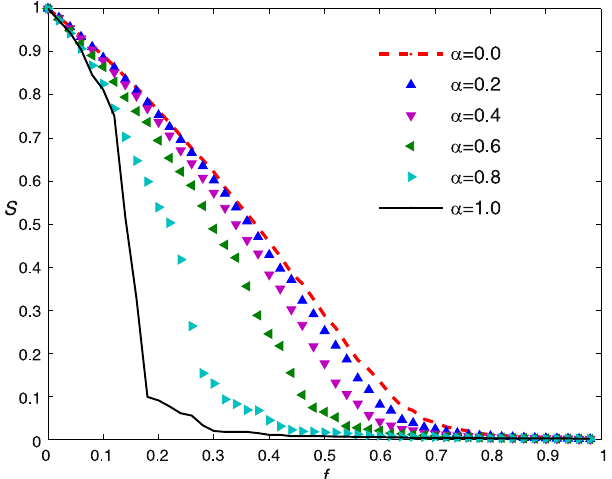
Figure 3. The relative sizes of the largest component S versus f for various attack information perfection parameter α . The original network is the same as the one we used in Fig. 2. The simulation results are averaged over 100 independent realizations of imperfect attack information.